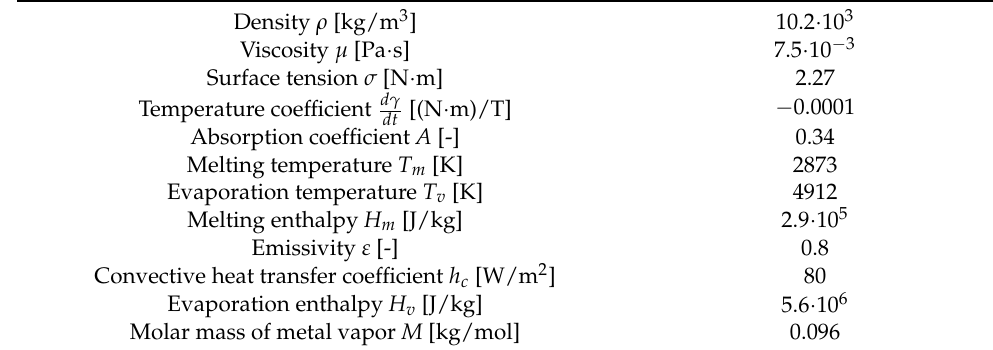
Table 1. Molybdenum alloy and argon gas-related material properties taken from the material